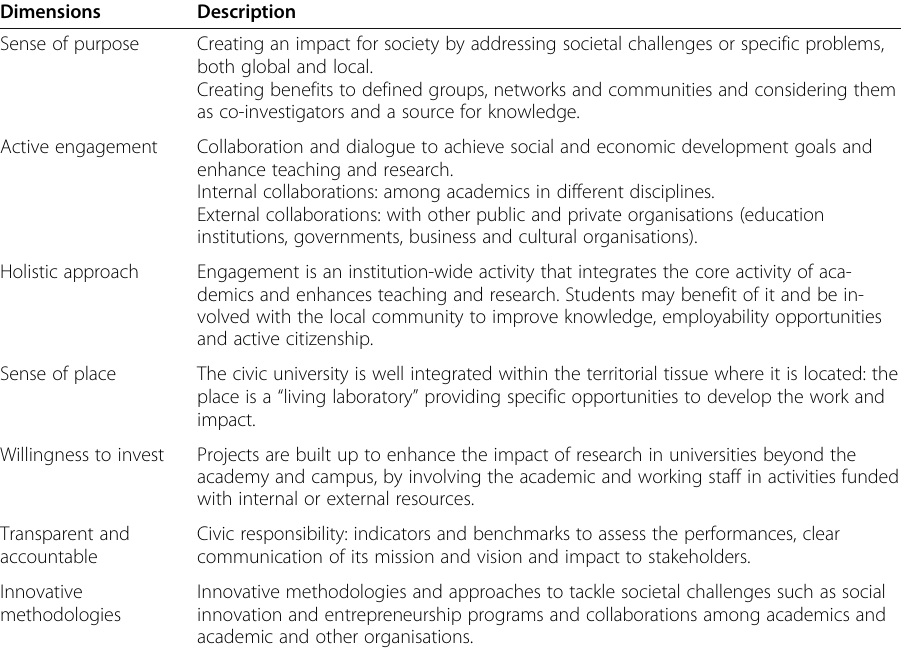
Table 1 The civic university dimensions (Goddard et al., 2016)